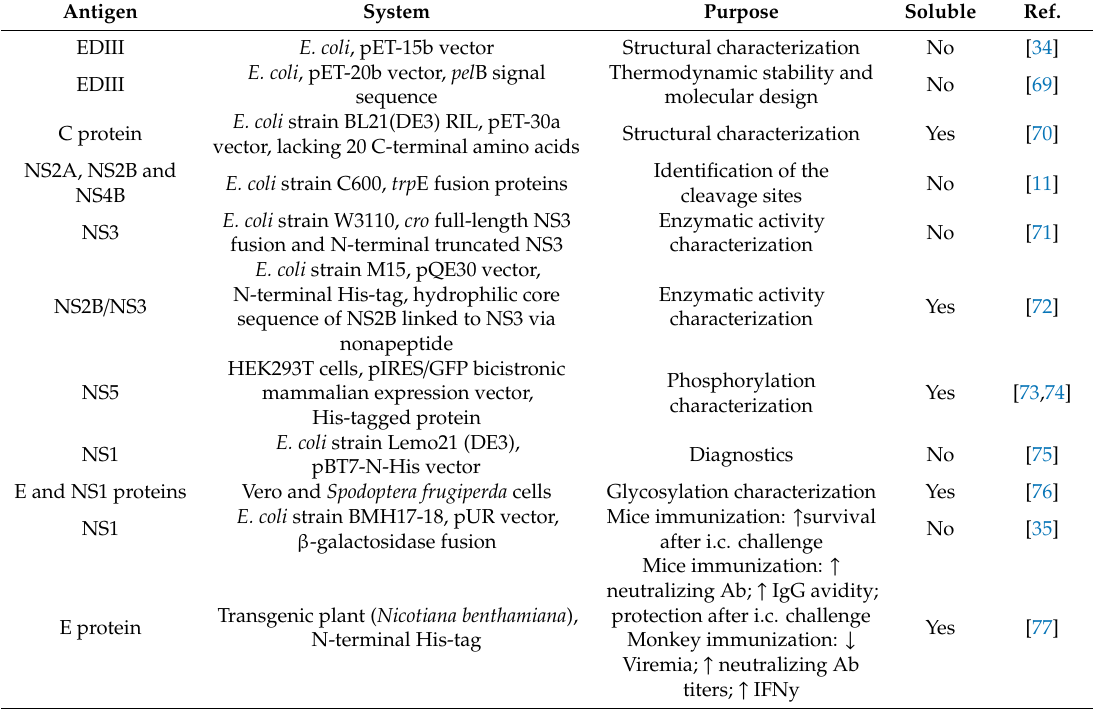
Table 1. Recombinant YFV antigens produced in Escherichia coli and other systems. Antigen System Purpose Soluble